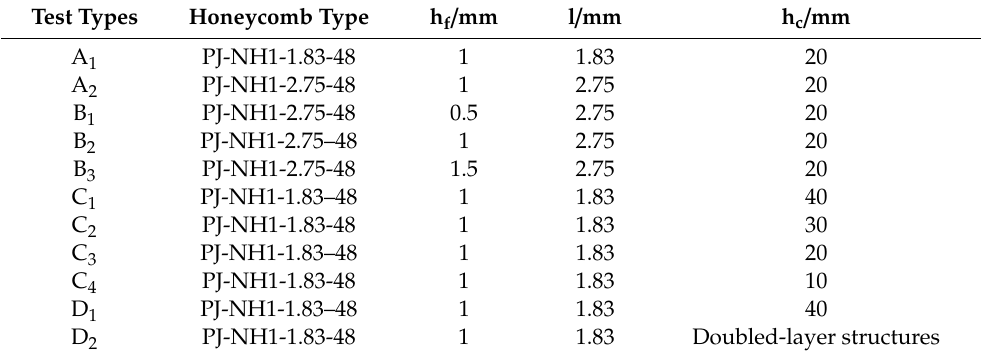
Table 1. The types of honeycomb sandwich structures used in the tests and their corresponding parameters.